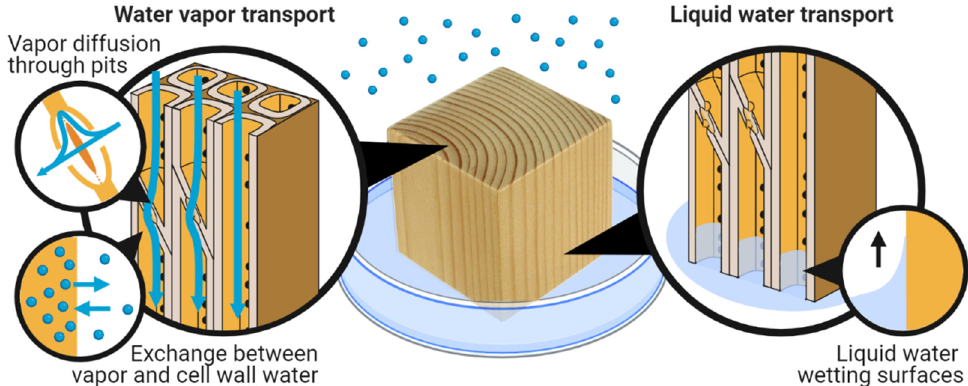
Figure 7. Transport of water in wood. The porous, macro-void structure (lumina, pits, etc.) facilitates the transport of both water vapor by diffusion and liquid water by capillary action (wetting). Cell wall water is transported in the solid cell walls by diffusion (not shown). There is a continuous exchange of water molecules at the interface between cell walls and macro-voids, here exemplified by the exchange between vapor and cell wall water.